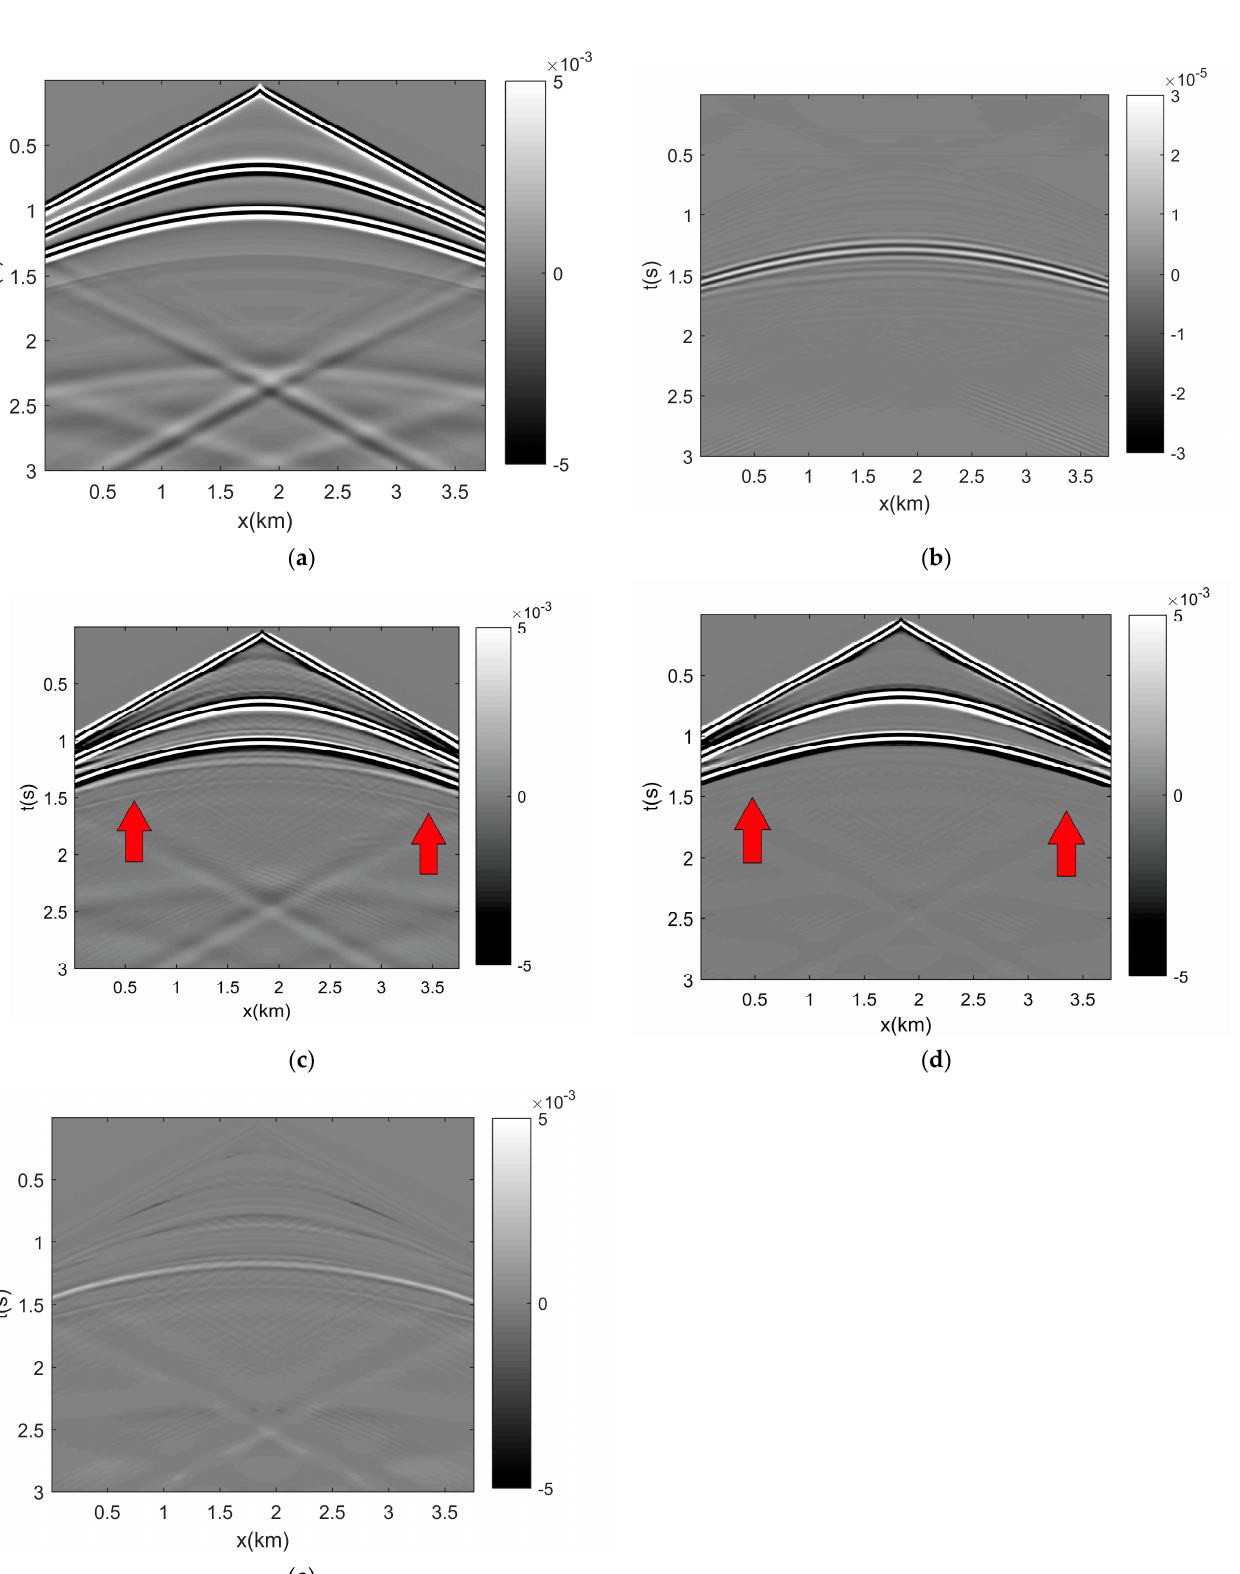
Figure 4. ( a ) Recorded data. ( b ) Predicted internal multiples after five iterations. ( c ) The data residual after five iterations. ( d ) The primary of data residual after using the weighting matrix ( e ) The internal multiples of data residual after using the weighting matrix.